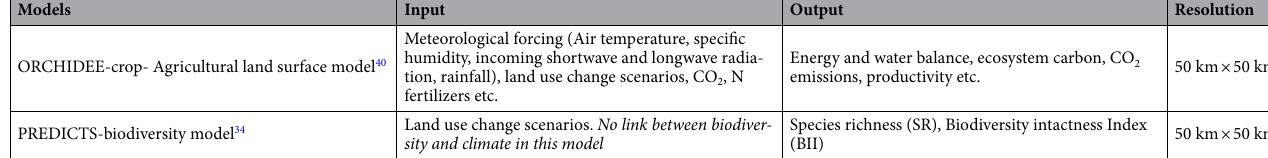
Models ORCHIDEE-crop- Agricultural land surface model 40